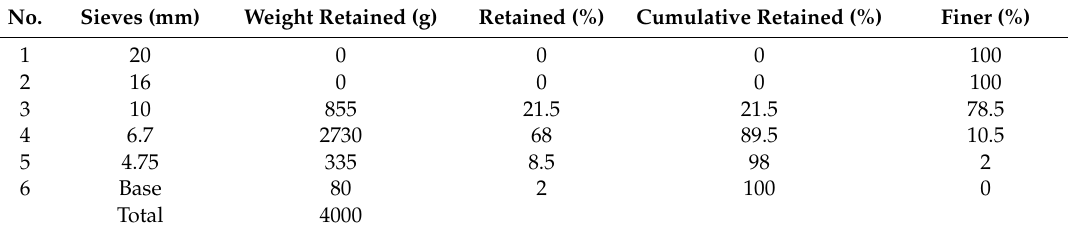
Table 3. Gradation of aggregates.